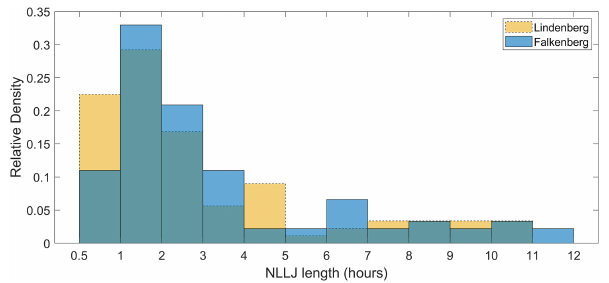
Figure 7. Lengths of NLLJs color-coded for the two sites. The data filtering implies that events shorter than 30min are removed prior to the data